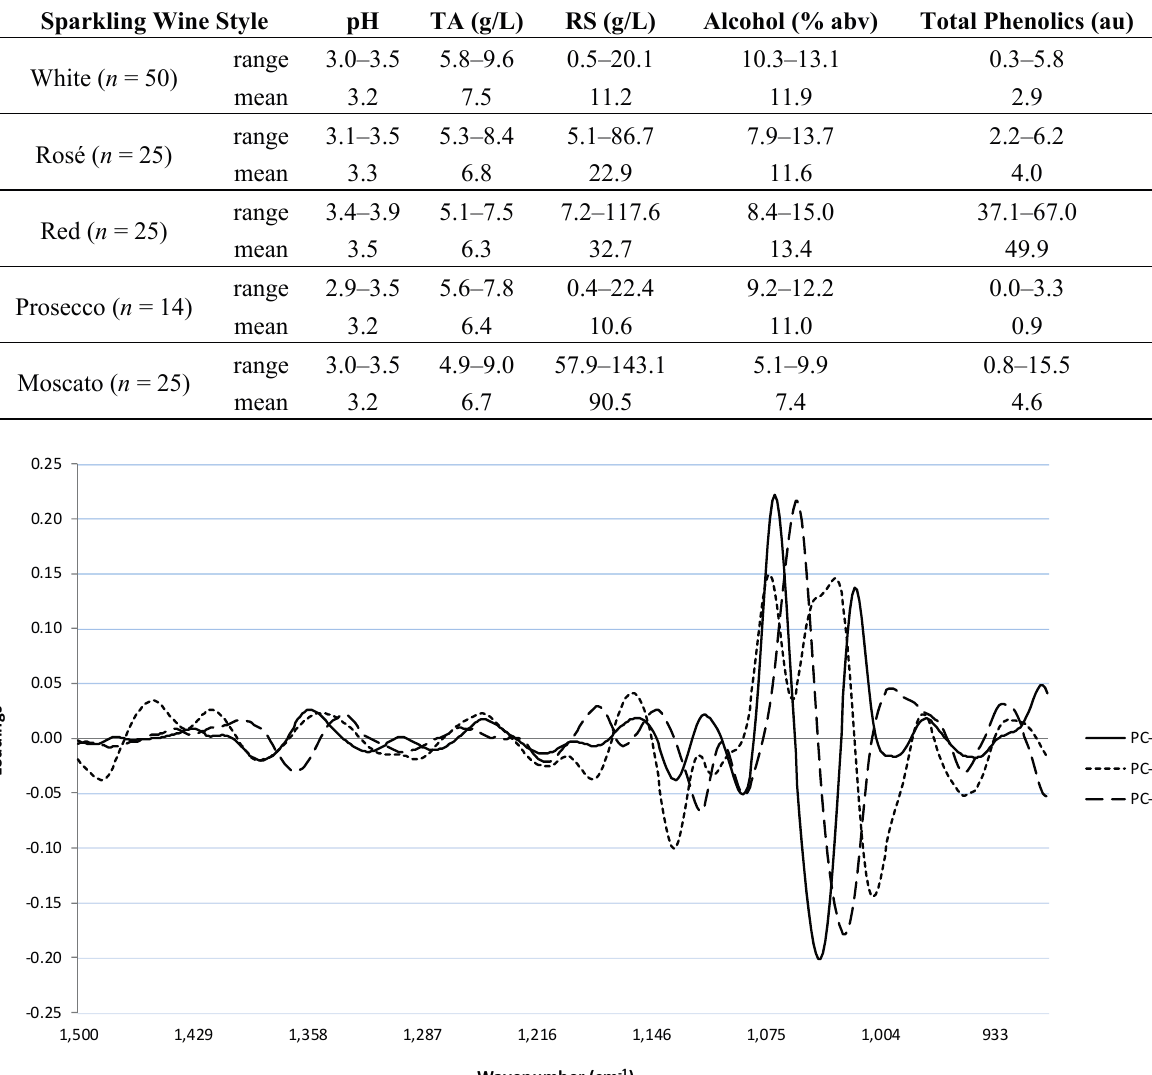
Table 1. Composition of the different styles of sparkling wine studied.